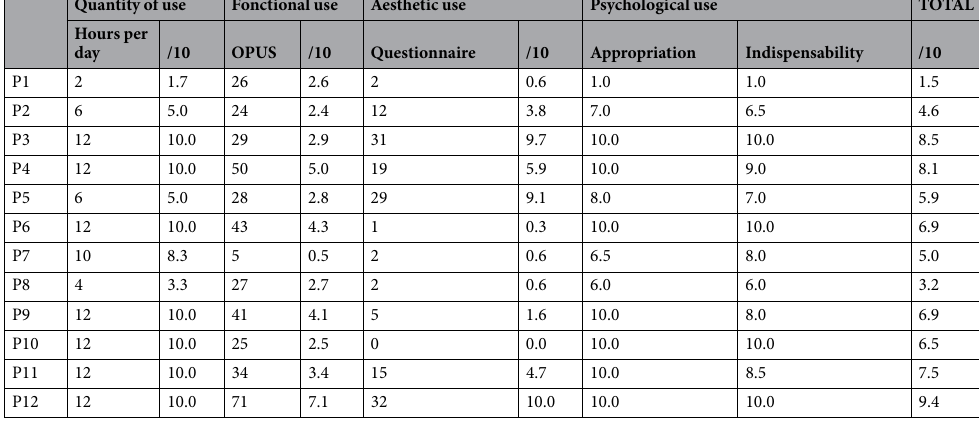
Table 2. Integration score. Weighting: Total = 4 * Quantity of use + 2 * Functional use + 2 * Aesthetic use + Subjective appropriation +